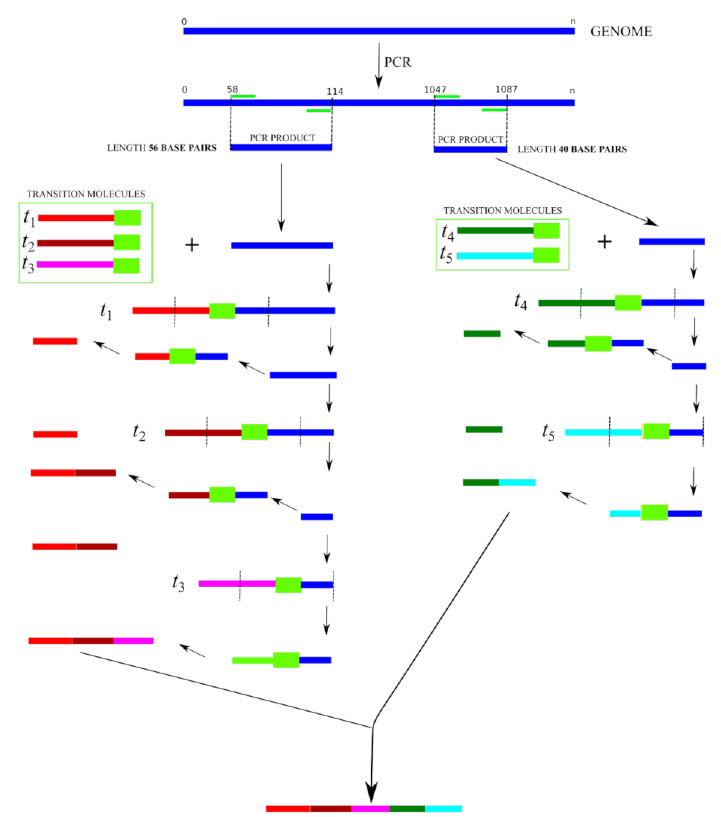
Figure 7. Diagram Queue-PCR of a new PCR automation concept of the use of biomolecular computers with type queue memory based on type IIB restriction endonuclease. The first step of Queue-PCR concept is replication of selected DNA fragments and the next step is sequential cutting and ligating DNA molecules by means of molecular software and hardware. Abbrevia- tions: t 1 , t 2 , t 3 , t 4 , t 5 —respective transition molecules (molecular software); PCR—conventional PCR method; the numbers: 58, 114, 1047, 1087 denote positions on the genome. The blue line denotes the genome fragment multiplicated by the PCR. The green rectangle denotes the sequence recognized by type IIB restriction endonuclease (molecular hardware). The DNA fragments amplify by PCR are denoted by blue color. The restriction sites are denoted by light green color. The remaining colors schematically illustrate the queue